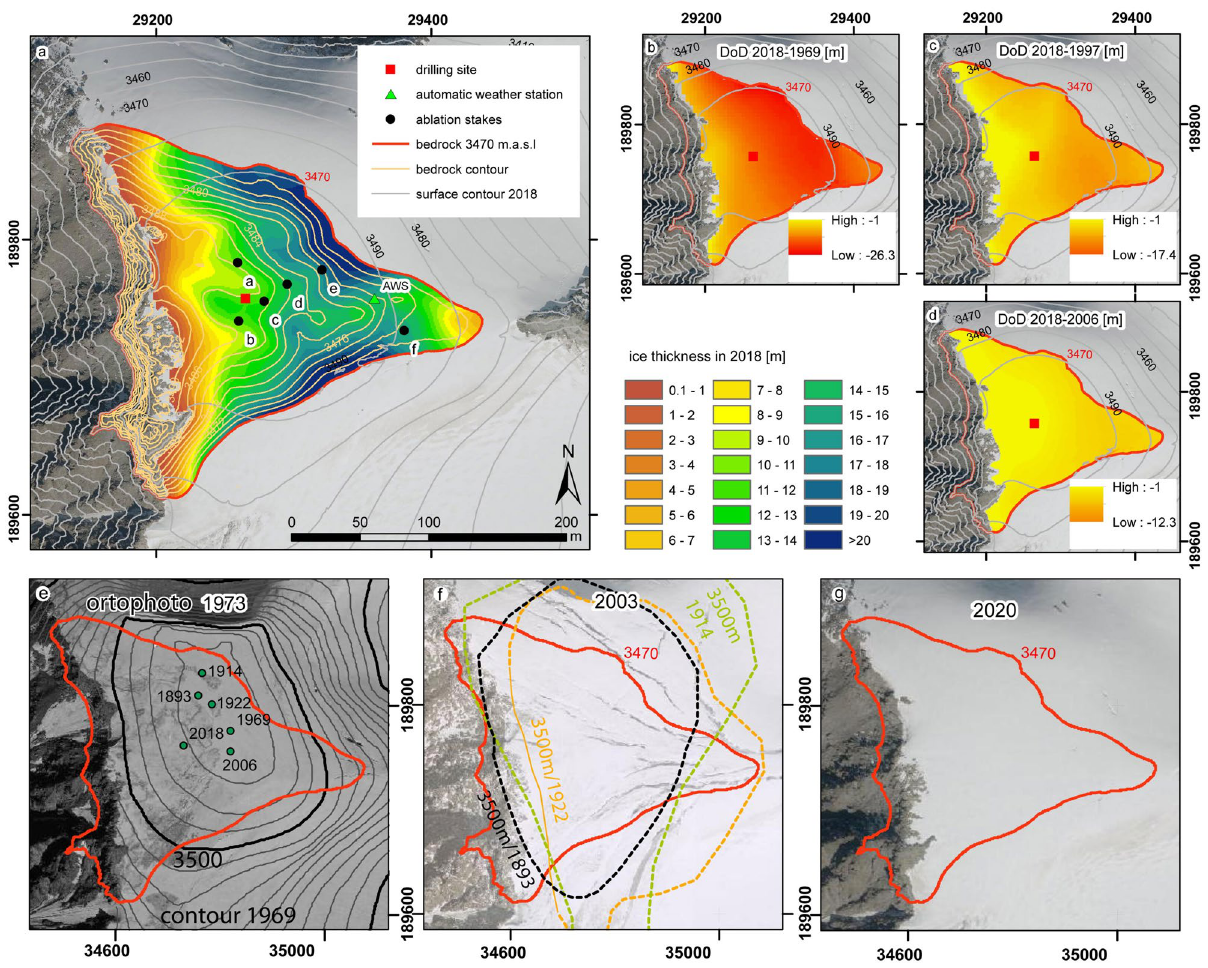
Figure 3. Bedrock topography from the GPR measurements and calculated ice thickness in 2018 ( a ). The region above the 3470 m bedrock contour was chosen as area of interest for comparing maps of thickness change (DEMs of Difference, DODs) for the periods 2018–1969 ( b ), 2018–1997 ( c ) and 2018–2006 ( d ). The position of the measured maximum altitude and the past contour lines of elevation shows that all of them are located within the 3470 m bedrock altitude band ( e ), as well as above the 3520 m contour line of 1969, and that past cartographers drew the 3500 m contour line in order to represent the dome shape evident from the photographs ( f ). The orthophotos of 1973 are the only available ones so far where signs of melt at the summit dome are evident, as ( e–g ) demonstrate. This figure was compiled with Adobe Illustrator CS4 version 14.0.0 (www. adobe. com). The maps were created with ArcMap 10.6.1 (www. arcgis. com).